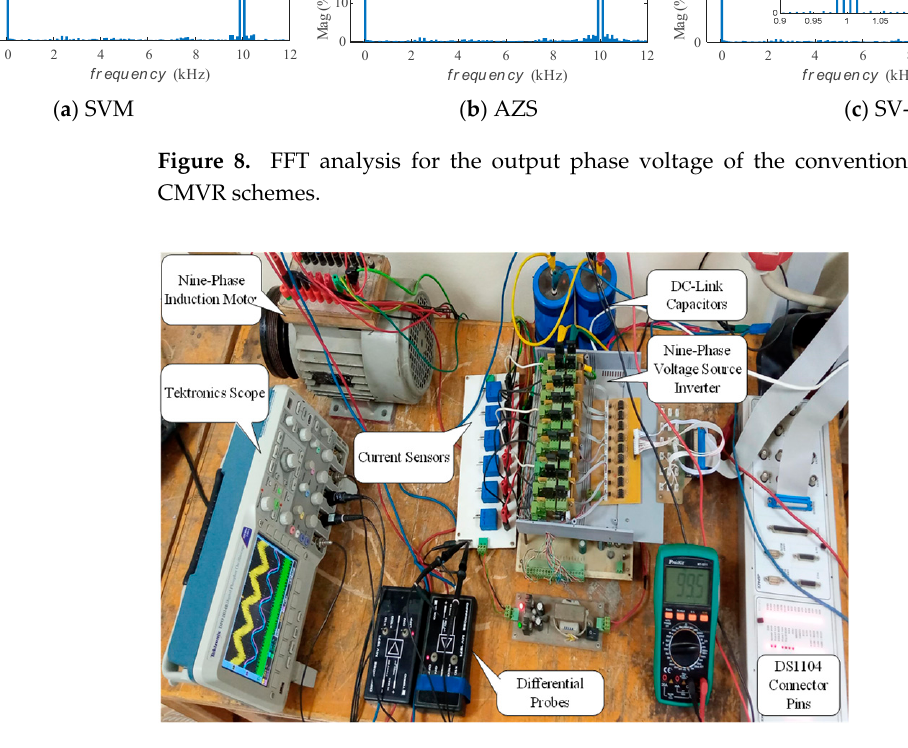
Figure 9. Experimental Setup.